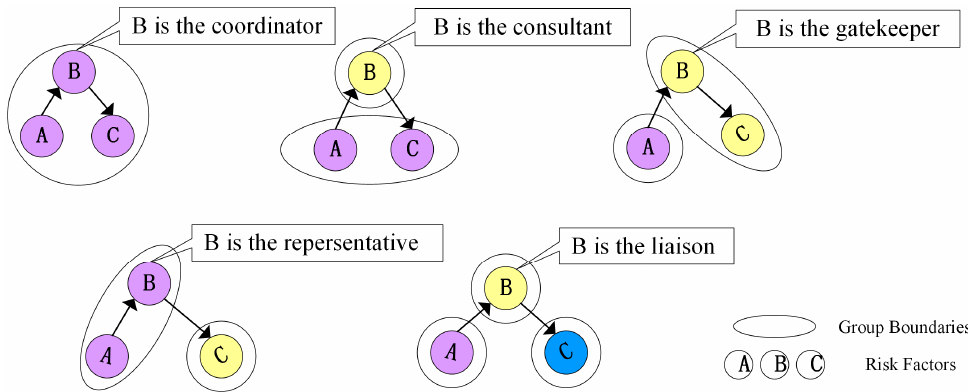
Figure 4. Description of the five types of intermediaries.